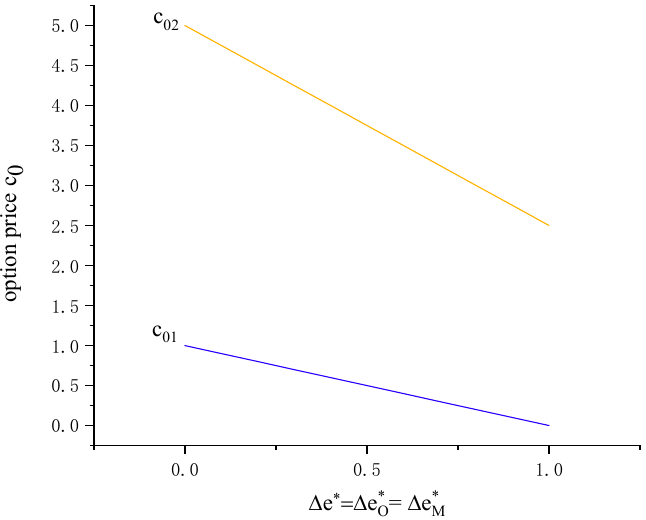
Figure 7. Range of option price ( p = 20, w = 10, v = 4, t = 0.5, e = 2, c e = 5).